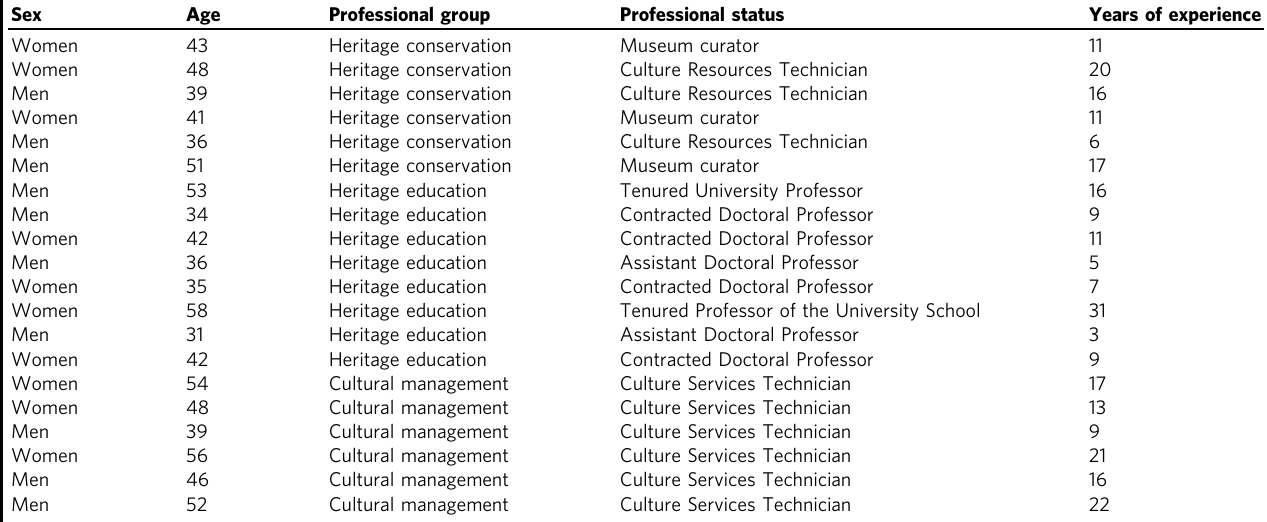
Table 2 Demographic and professional pro fi les.